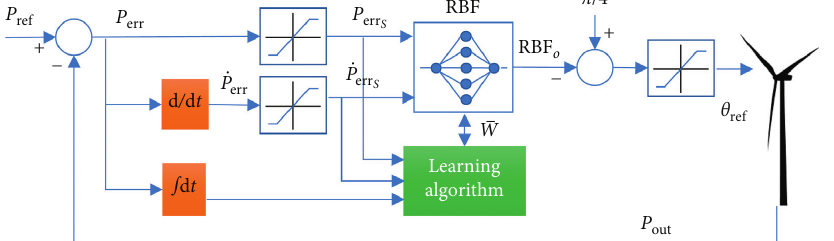
Figure 1: Architecture of the neural controller.